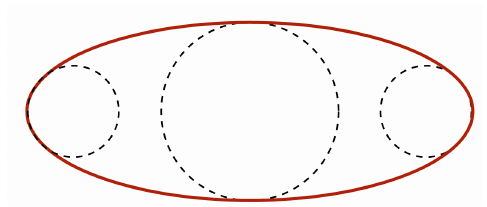
Figure 1. Incision behavior in the points retraction process. each retraction point represent Mohr’s circle, but together the points replicate a Lamé ellipse.